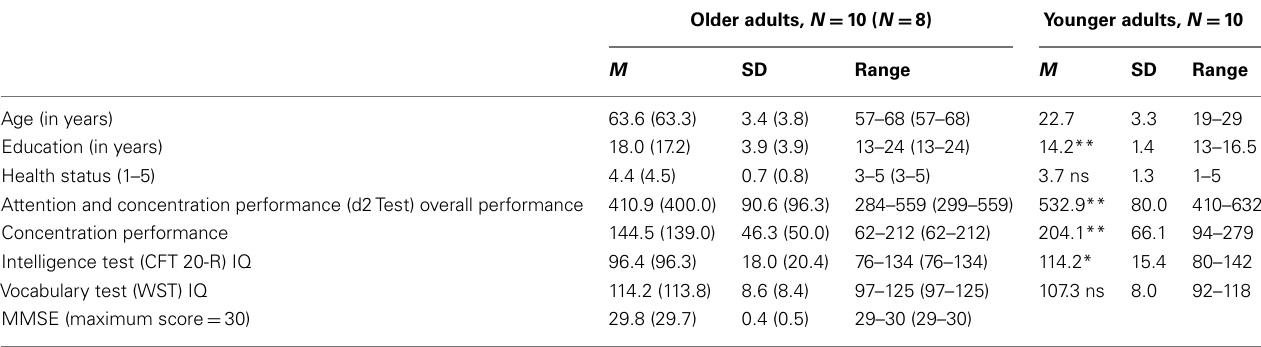
Table 3 |Age, formal education, general health status, attention performance, non-verbal intelligence, and vocabulary knowledge for older and younger adults; MMSE (mini-mental state examination) scores for older adults only; CFT 20-R, cultural fair intelligence test,WST, Wortschatztest (vocabulary